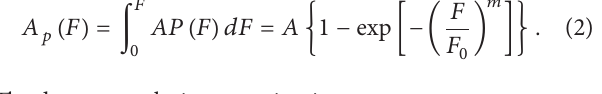
Figure 1: The viscoelastic damage model of shale.